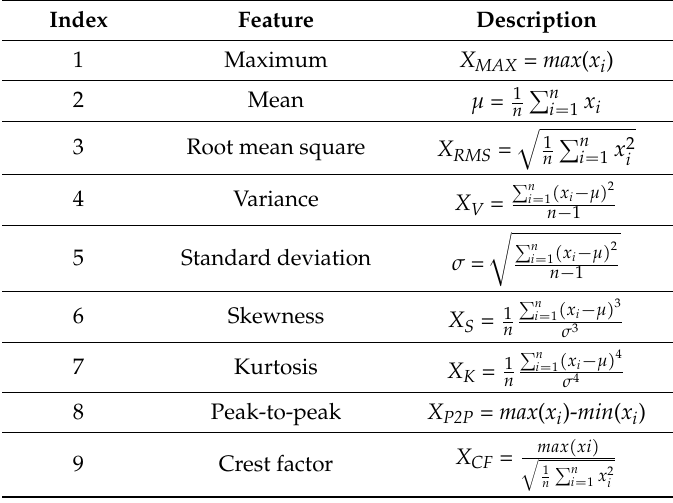
Table 2. Features extracted in frequency domain.